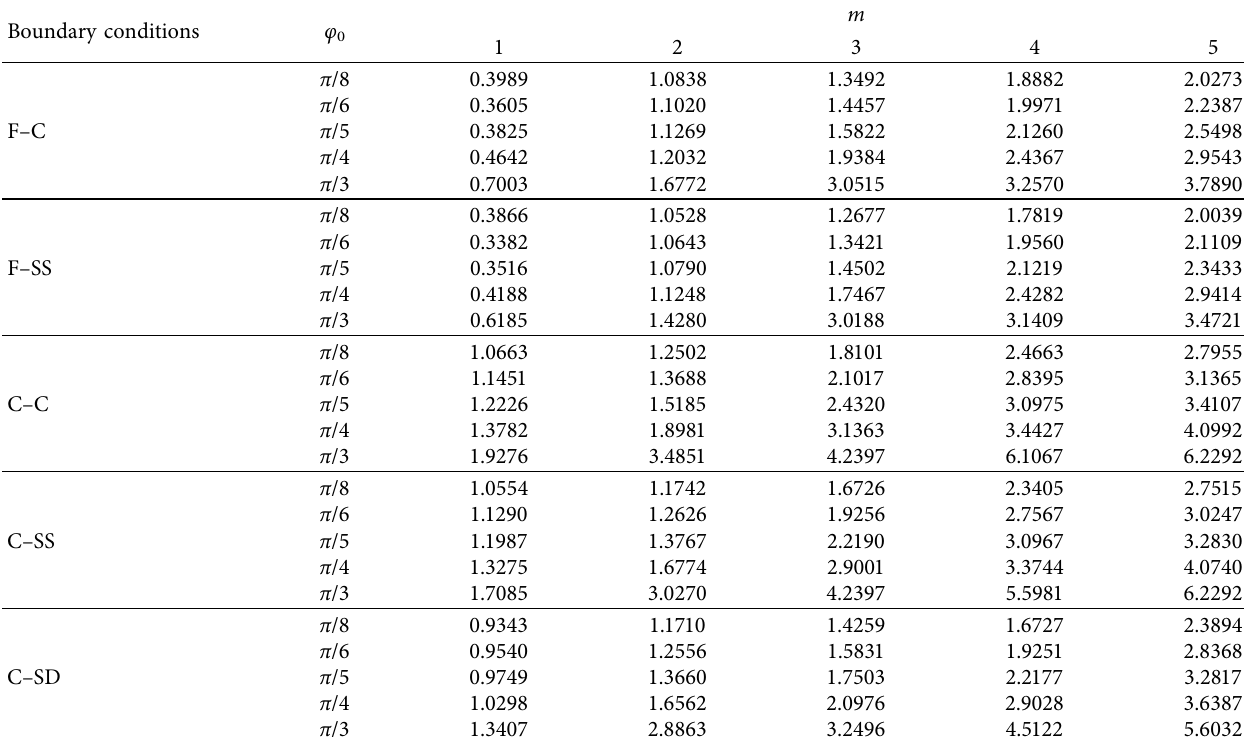
� π /2, R � 1m, h � 0.06m, and n � 0 ( φ 1